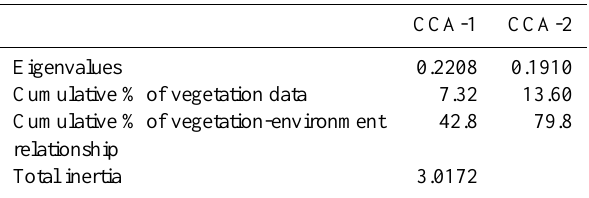
Table 3. Canonical correspondence analysis of the vegetation and environmental data gathered in four habitat types in the Qarlikturvik valley, Bylot Island, Nunavut. CCA-1: first canonical axis; CCA-2: second canonical axis.